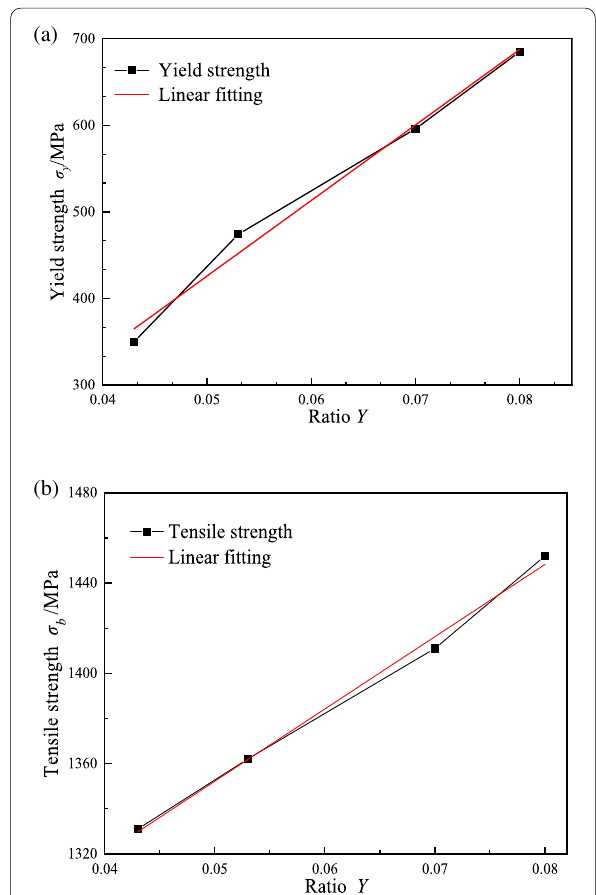
Figure 13 (a) Fitting curve of yield strength and ratio Y , (b) fitting curve of tensile strength and ratio Y